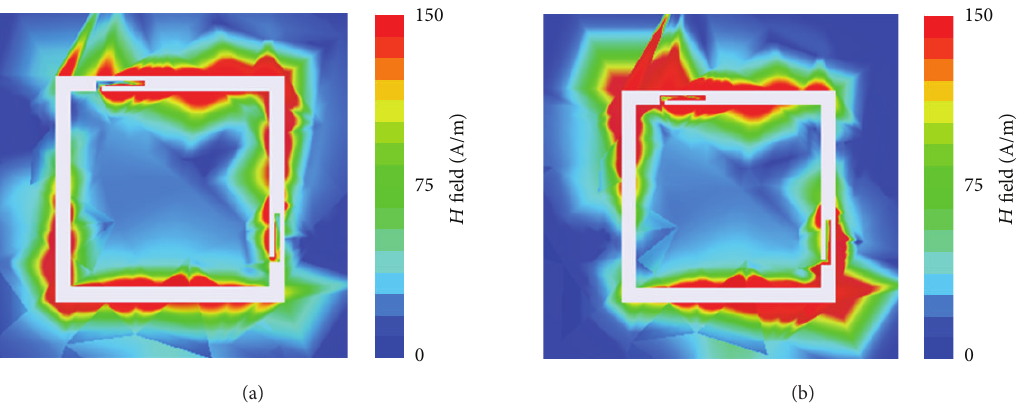
Figure 5: Simulated current distributions for two degenerate modes with a Chebyshev characteristic (spurline on corners A and C): (a) = 7.45 GHz; (b) 𝑓 = 7.63 GHz. 𝑓 1 2